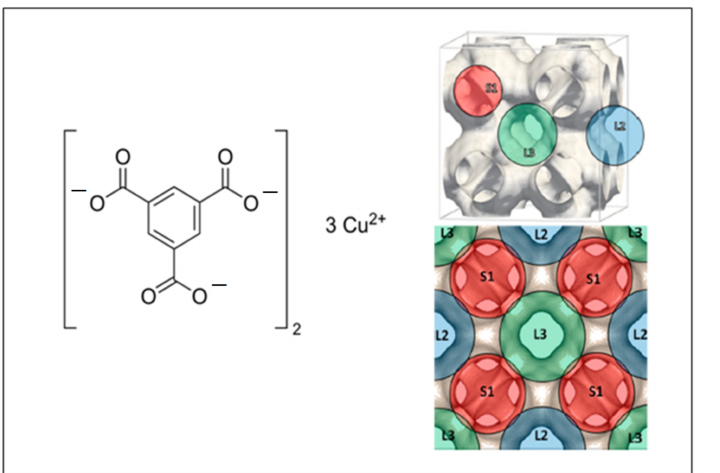
Figure 1. ( Left ) Molecular formula of Cu-BTC unit. ( Right ) Three-dimensional view (top) and front view (bottom) of the Cu-BTC unit cell with pockets S1 and cages L2 and L3. The right side of the figure is reprinted with permission from [30]. Copyright 2013 American Chemical